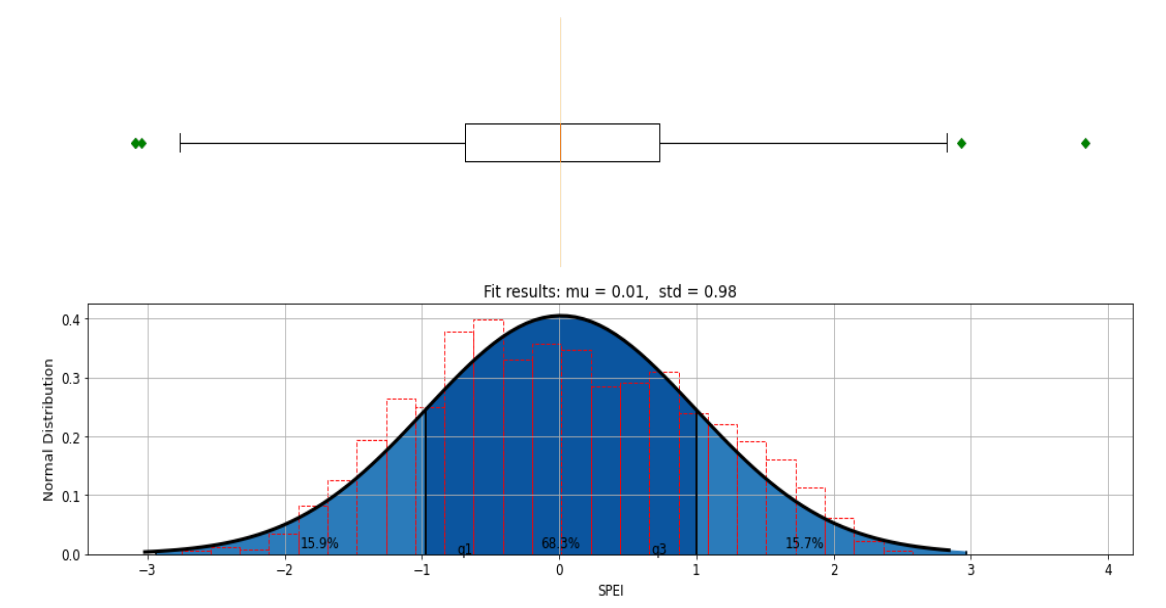
Figure 4. Normal distribution of the SPEI data.